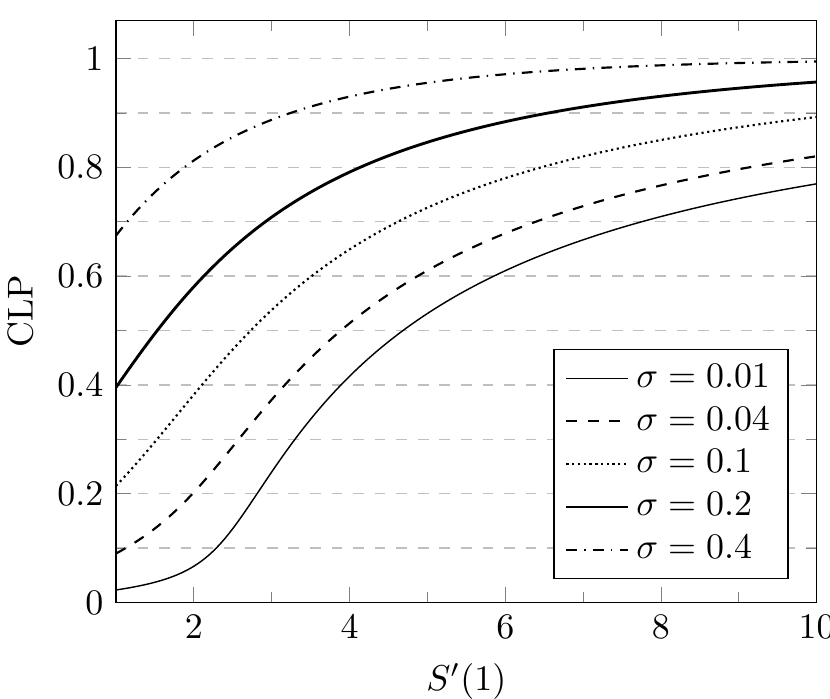
Figure 8. Customer loss probability CLP versus S (cid:48) ( 1 ) for Poisson service times, Poisson arrivals with λ = 0.4 and different values of σ